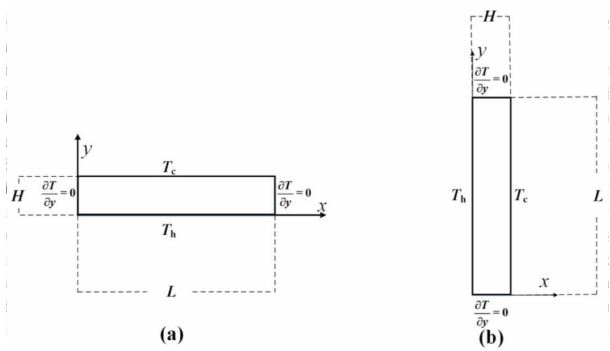
Figure 1. Enclosure schematic model: ( a ) horizontal enclosure; ( b ) vertical